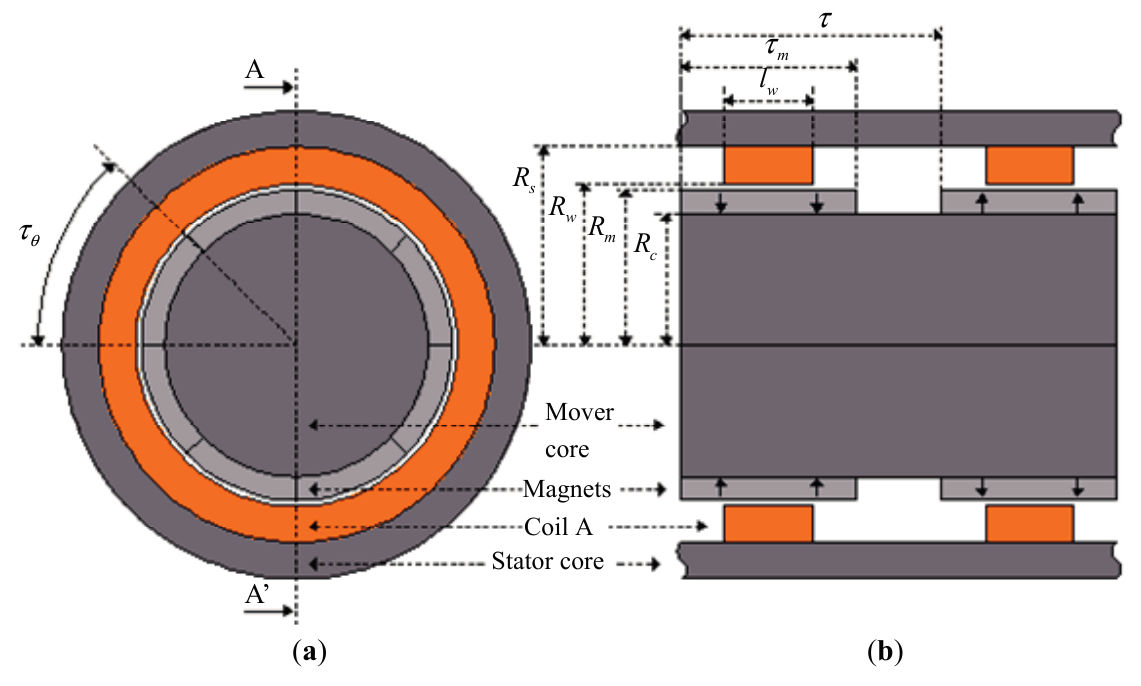
Figure 2. Linear cylindrical actuator showing ( a ) axial view and ( b ) view of section